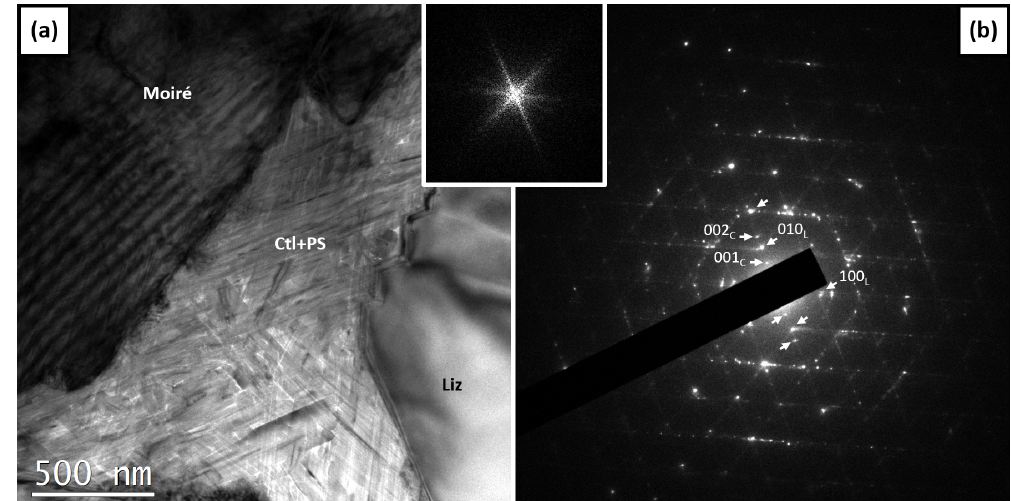
Figure 4. TEM results. (a) BF image of [001] lizardite, intermixed with abundant chrysotile. Moiré fringes, i.e. interference features due to superposition of flat periodic objects (possibly serpentine grains) in different orientations, are visible in the upper left. The fast Fourier transform (FFT) of the central portion (inset) shows “star” intensity distribution suggesting preferred fibre orientation, rotated about n 60 ◦ (equivalent to 120 ◦ ) relative to each other. (b) SAED pattern of lizardite plus chrysotile; the chrysotile diffractions (spots and streaks), parallel to the lizardite lattice, indicate crystallographic control on the chrysotile orientation. Some basal lizardite reflections (left-pointing arrows) and some 00l chrysotile reflections (right-pointing arrows) are indicated, and some are